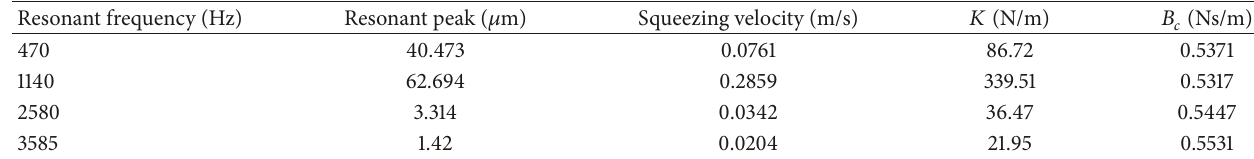
Table 1: 𝐾 and 𝐵 𝑐 introduced by ferrofluid at each resonant frequency.